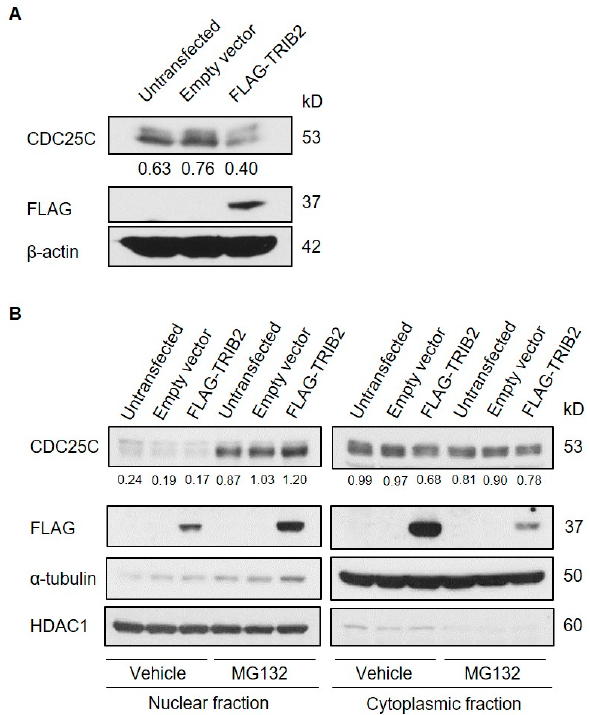
Figure 2. TRIB2 promotes proteasome-dependent degradation of CDC25C in the nucleus. ( A ) Whole cell lysates from FLAG-TRIB2-transfected HeLa cells and controls (untransfected and empty vector-transfected) were analyzed by Western blotting; ( B ) cells were treated with dimethylsulfoxide (DMSO-vehicle) or 10 µM of MG132 for 4 h before subcellular fractionation for Western blotting analysis. α -Tubulin and HDAC1 are cytoplasmic and nuclear markers respectively. CDC25C signals were quantified by densitometry analyses and normalized to the respective loading control signals. The normalized values were indicated below the sub-panel.